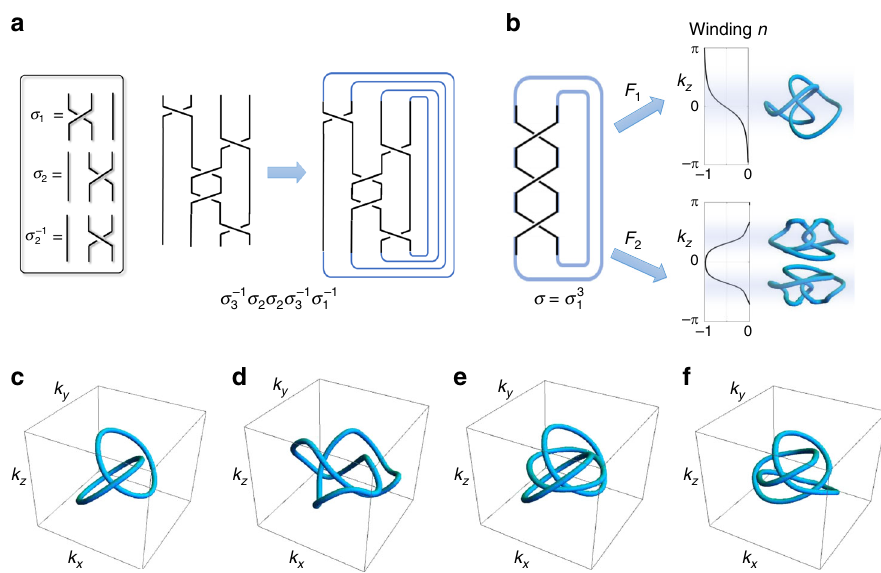
Fig. 1 Nodal knots from braids. a Braid operations σ i and σ (cid:1) 1 i represent the over/under-crossing of strand i with strand i + 1 as we travel upwards. A braid consists of a series of braid operations, and can be closed to form a knot or link (in this case it is a link between three loops). b A braid closure can be embedded onto the 3D BZ torus in different ways through different choices of F ( k ). Depending on its topological charge density distribution of Eq. (4), it can produce different numbers of copies of the knots in the BZ, i.e. one a single copy ( F 1 ) or two mirror imaged copies ( F 2 ). c – f Various examples of simple Nodal knots/links de fi ned by Eq. (3), some of which we shall explicitly construct in circuits band structures later. c Hopf-link with σ ¼ σ 2 ( z , w ) = ( z − w )( z + w ). d) Trefoil knot with σ ¼ σ 3 and f ( z , w ) = ( z − w 3/2 )( z + w 3/2 ). e) 3-link with σ ¼ ð σ 1 σ 2 σ 1 Þ 2 and f ( z , w ) = z ( z 2 − w 2 ). f Figure-8 1 σ Þ 2 and f ð z ; w Þ ¼ 64 z 3 (cid:1) 12 z ð 3 þ 2 ð w 2 (cid:1) (cid:2) w 2 ÞÞ (cid:1) 14 ð w 2 þ (cid:2) w 2 Þ (cid:1) ð w 4 (cid:1) (cid:2) w 4 Þ 35 knot with σ ¼ ð σ (cid:1) 1 1 2